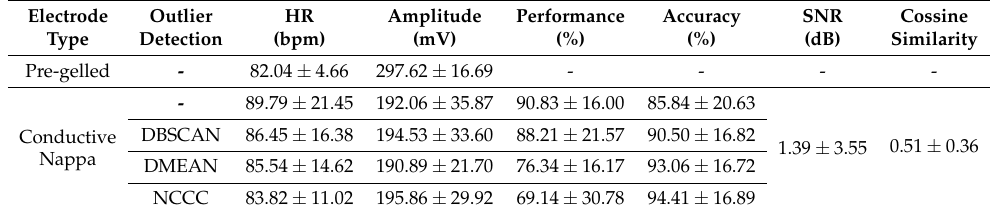
Table 3. Comparative analysis of the heart rate and R-peak amplitude determined for the ECG time series obtained with the pre-gelled electrodes and with the conductive nappa, and SNR and cossine similarity between the scaled version of these